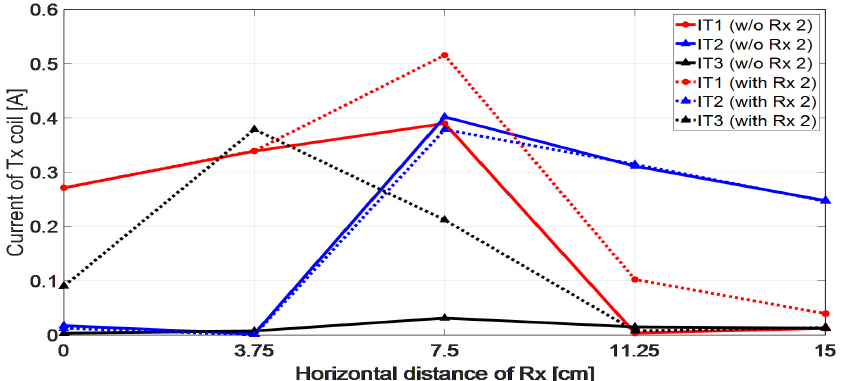
Figure 4. the current change of the Tx coil when the Rx 2 comes into the charging